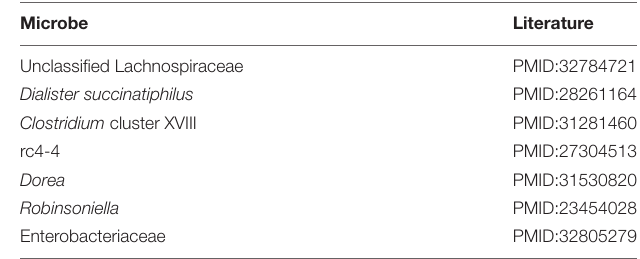
TABLE 3 | Literature verification of the predicted obesity-related